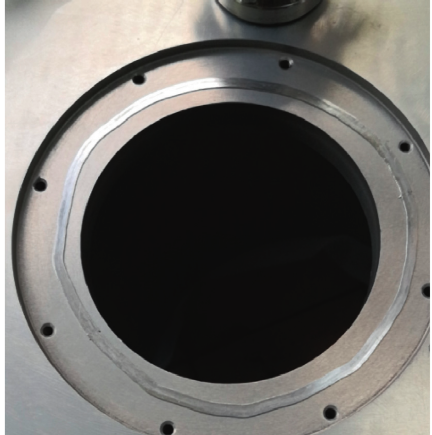
Figure 3: Metal seal in the interface.